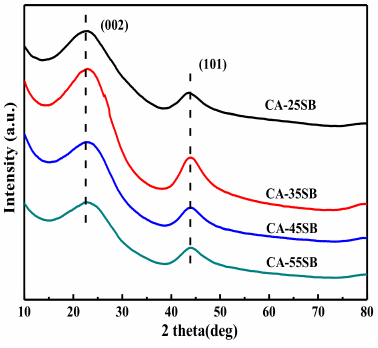
Figure 1. XRD patterns of CA-X samples.